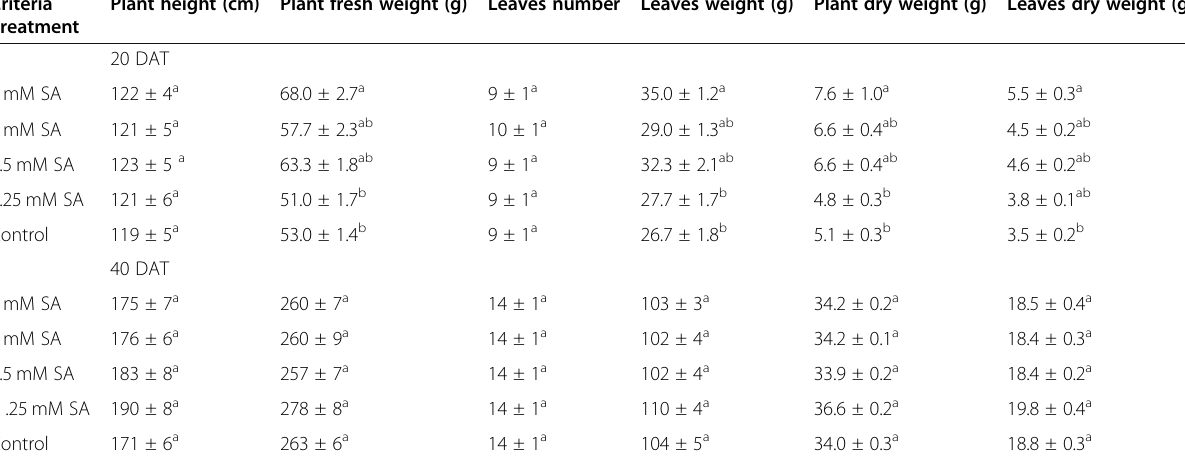
Table 4 Effect of SA foliar spray on vegetative growth of maize plants Criteria Treatment